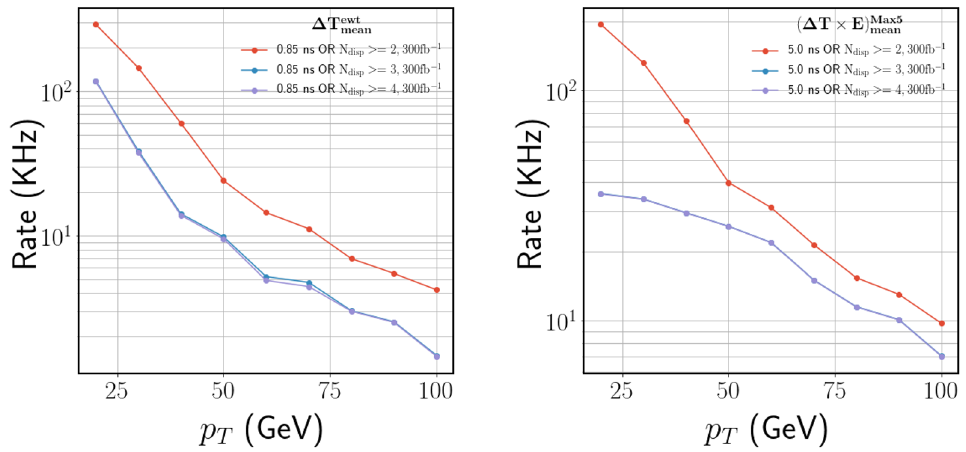
Figure 11 . Rate of background events as a function of jet p T with the combination of varying cuts on the ∆ T Ewt ( left ) and (∆ T × E ) max 5 ( right ) timing of the jet for ECAL timing resolution mean mean corresponding to integrated luminosity of 300 fb − 1 and number of displaced L1 tracks inside a jet within ∆ R = 0 . 3 at ECAL, in the 140 PU